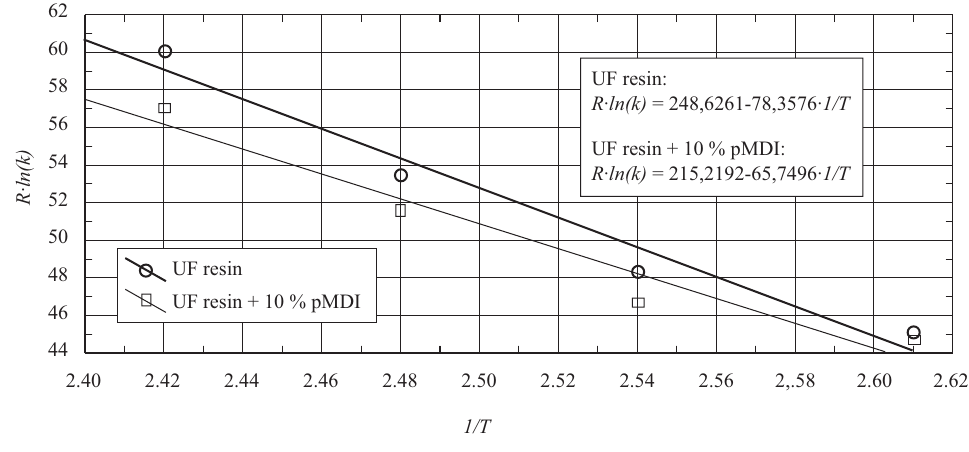
Figure 3 Reaction rate constant depending on temperature of pure UF resin and UF/pMDI glue mixture gel time Slika 3 . Ovisnost konstante brzine reakcije o temperaturi čiste UF smole i o vremenu želiranja smjese ljepila